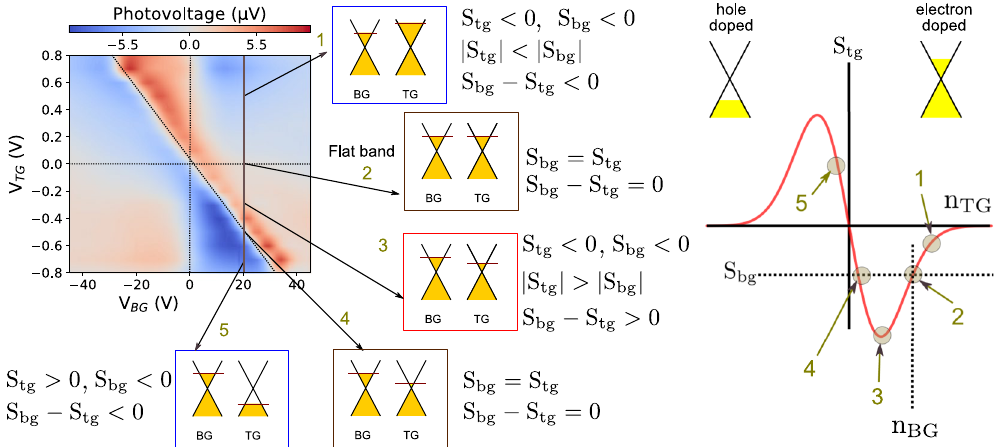
Figure 4. The magnitude and signs of the Seebeck coefficient that leads to the six-fold pattern seen in the photovoltage data. Along the constant V BG line, the charge density in the covered region is constant and the exposed regions changes. The photovoltage is zero at point 2 and 4 where Seebeck coefficients are equal. The photovoltaic response is zero at point 2, which is the flat band condition where the Fermi levels in both regions are equal. At point 4, the photoresponse is zero despite unequal Fermi levels and provides evidence of the photothermoelectric effect. The plot on the right schematically shows the variation of S tg with n tg at fixed values of S bg and n bg . The existence of two distinct values of n tg where S tg = S bg leads to the two photoresponse zeros seen in Fig.